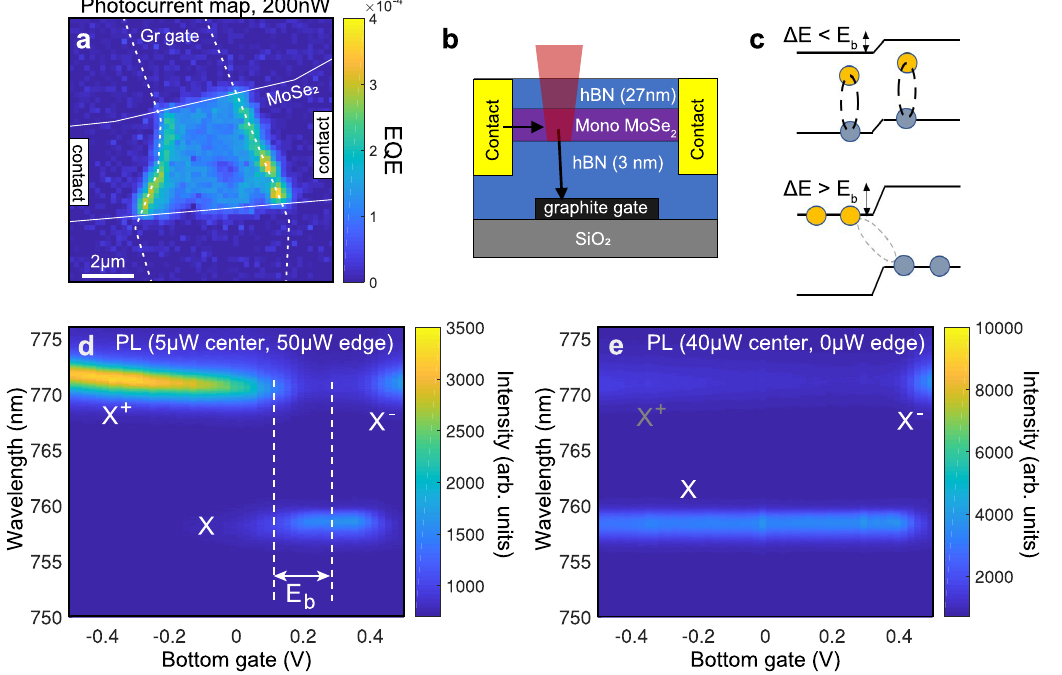
Figure 3: Photodoping via exciton dissociation at lateral potential